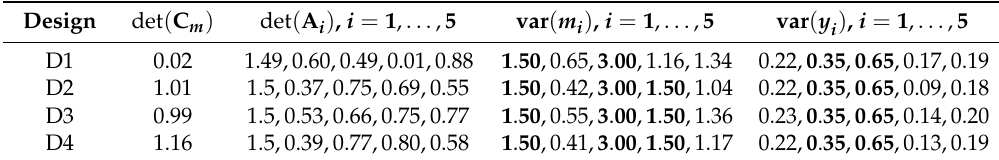
Table 7. Characterization of inputs and outputs for designs D1–D4 for a 5 × 5 FCC unit; active constraints are in bold.